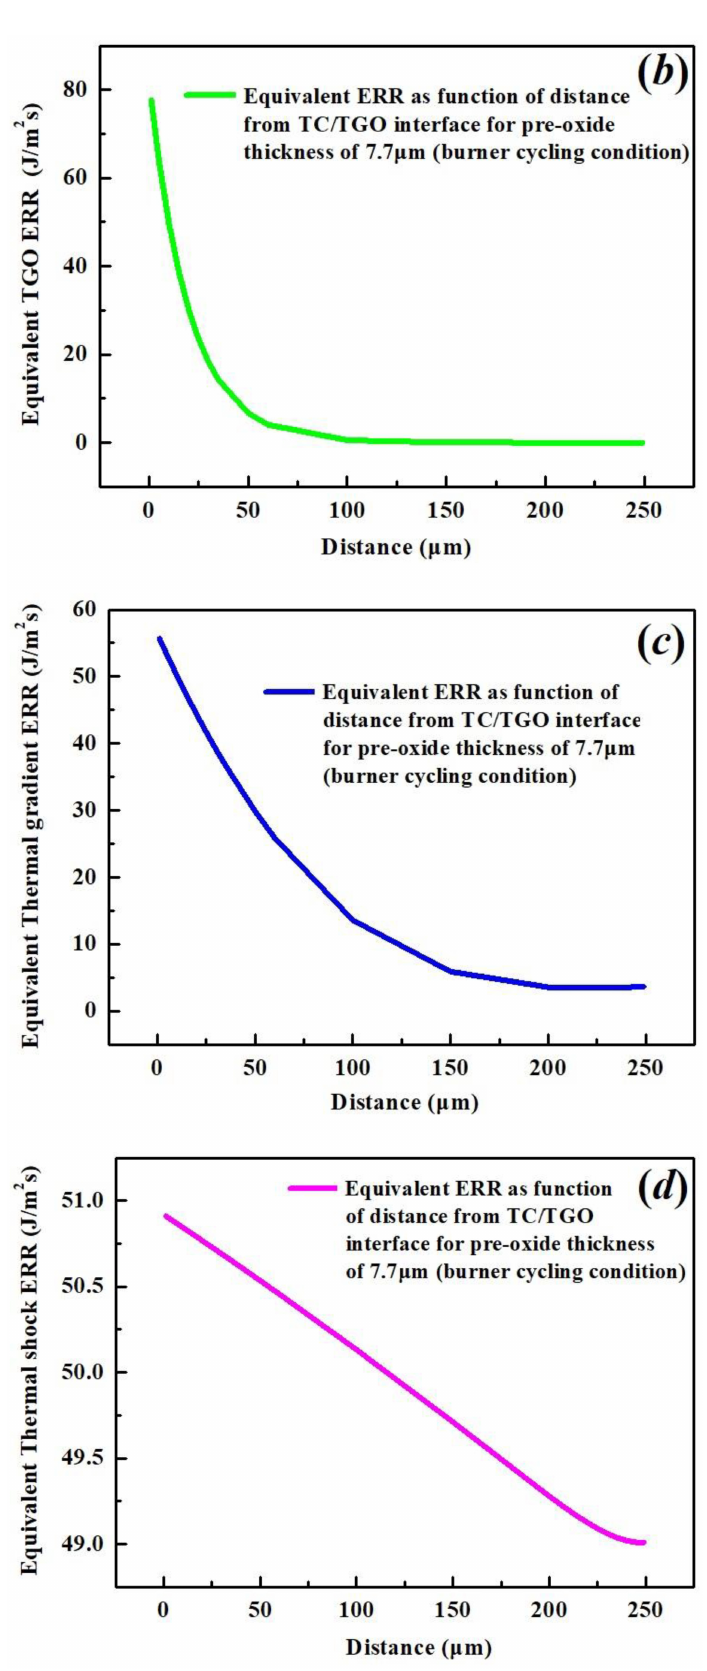
Figure 19. The calculated equivalent ERR vs. the distance away from TC/TGO interface under burner cycling test due to ( a ) CTE misfit; ( b ) TGO growth; ( c ) thermal gradient; and ( d ) thermal